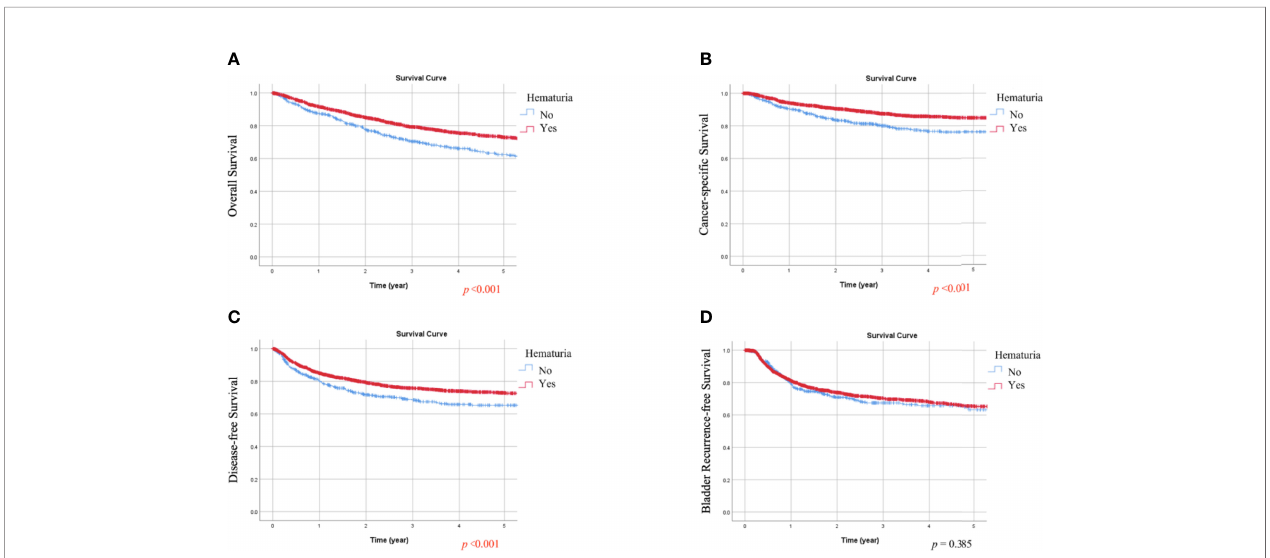
FIGURE 1 | Kaplan-Meier estimates of overall survival (A) , cancer-speci fi c survival (B) , disease-free survival (C) , and bladder recurrence-free survival (D) according to